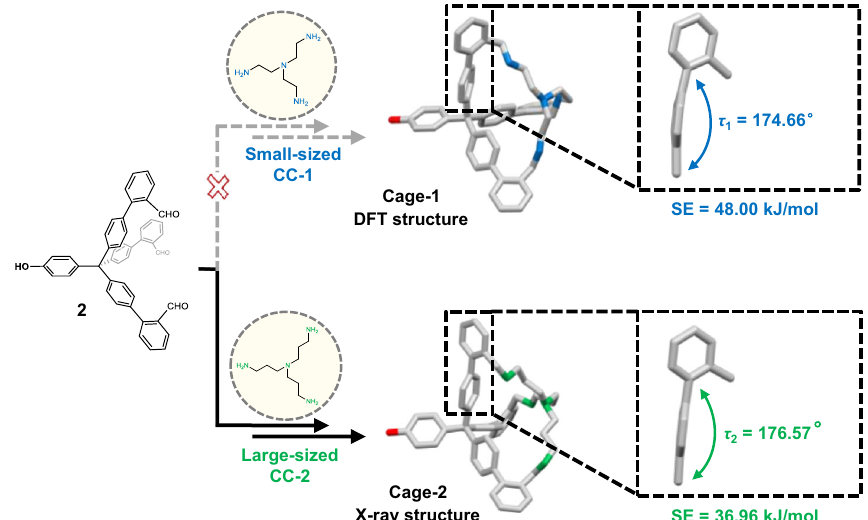
Fig. 5 Inspection of size effect of conformation capturers CC-1 and CC-2 with model compound 2. Small-sized CC-1 (blue) fails to form Cage-1, which is presented here with a geometry optimized structure (DFT, B3LYP-D3 in PCM with chloroform as solvent); While CC-2 (green) succeeds in yielding Cage- 2, with its molecular structure determined by X-ray crystallography. Hydrogen atoms and solvent molecules are omitted for clarity. The insets show the enlarged rigid arm of the two cages, revealing their torsion angles and the corresponding strain energies, respectively.